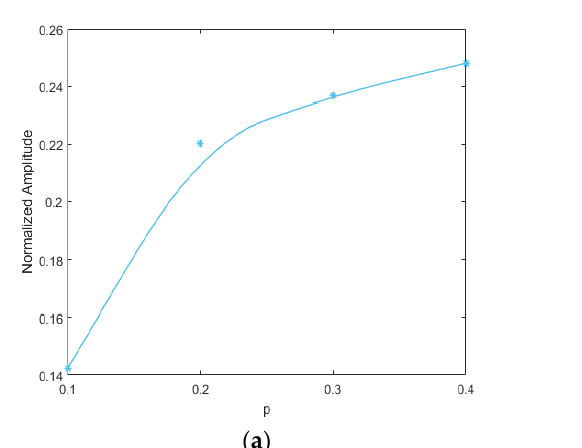
Table 3. Harmonic excitation parameters.